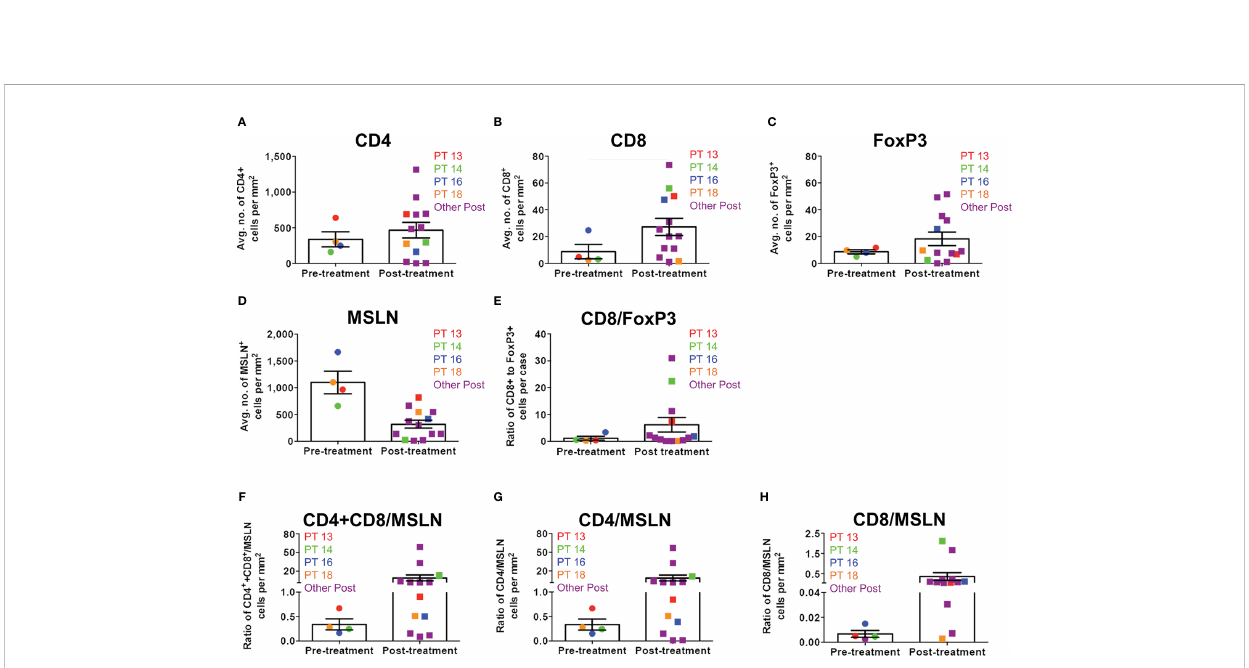
FIGURE 5 Immune cell in fi ltration ratios in all MPM tumor specimens before and after Olvi-vec therapy. (A – D) MPM tumor sections obtained before and after Olvi-vec therapy underwent multiplex immuno fl uorescence (mIF) staining and quanti fi cation of (A) CD4+ T cells, (B) CD8+ T cells, (C) FoxP3+ T cells, and (D) mesothelin (MSLN)+ tumor cells. (E) The ratio of CD8+ to FoxP3+ T cells (high ratio indicating relative immunogenicity, low ratio indicating relative immune suppression) in pre- and post-treatment tumor sections was calculated. (F – H) Ratios of (F) total T cells (CD4+ and CD8+) to MSLN+ tumor cells, (G) CD4+ T cells to MSLN+ tumor cells, and (H) CD8+ T cells to MSLN+ tumor cells were calculated. Bars indicate mean and